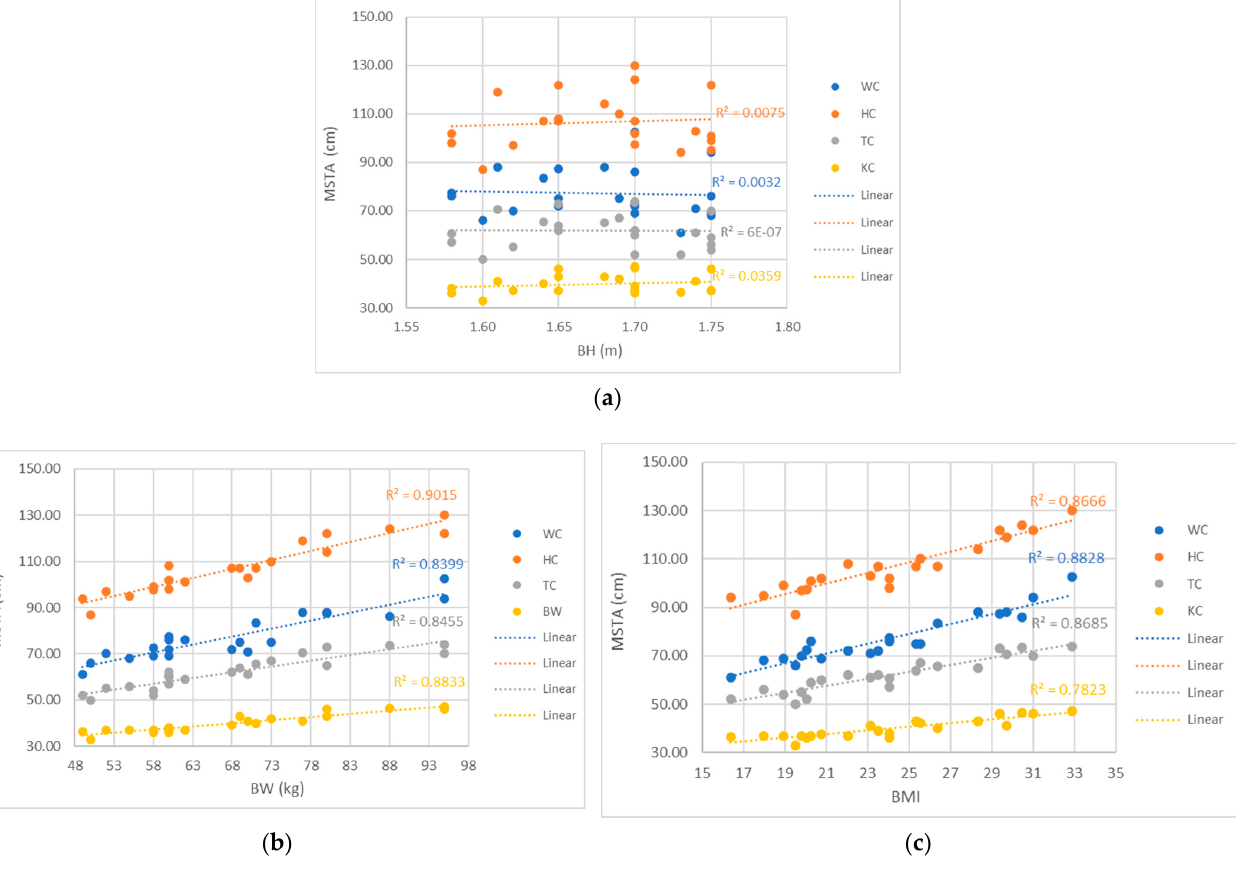
Figure 4. Influence of participants’ basic data on observed measurements of body circumferences in the standing posture (MSTA): ( a ) body height, ( b ) body weight, ( c ) body mass index.